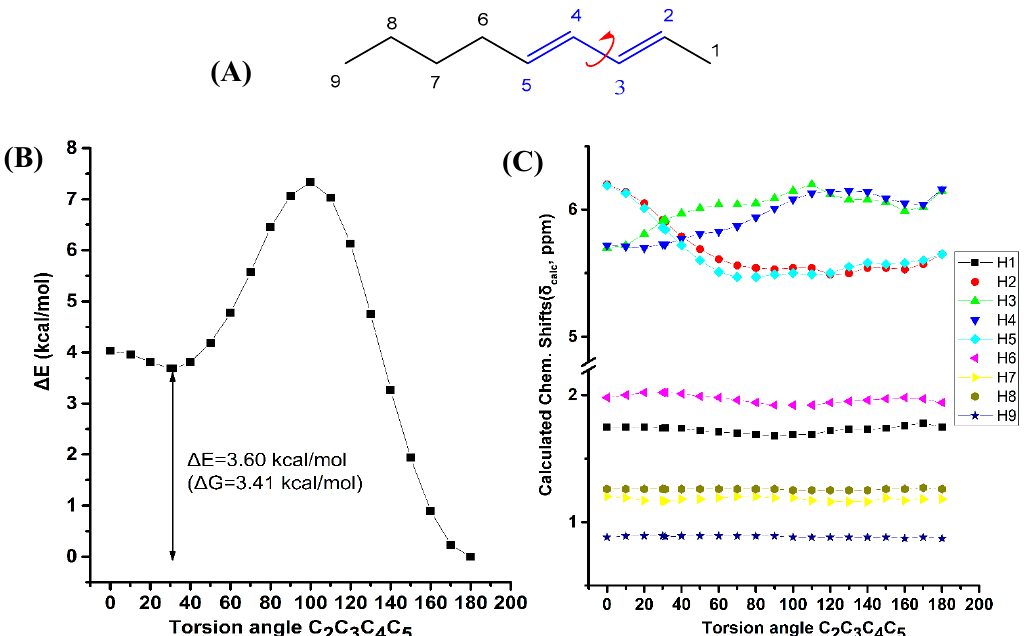
Figure 5. Effect of variation of the C 2 C 3 C 4 C 5 torsion angle of (E , E) -2,4-nonediene ( A ) on the electronic energy ΔΕ (kcal.mol − 1 ) ( B ), and the 1 H-NMR chemical shifts ( C ) with energy minimization at the B3LYP/6-31+G(d) level. The Gibbs energy difference, Δ G, of the two low energy conformers is also indicated.